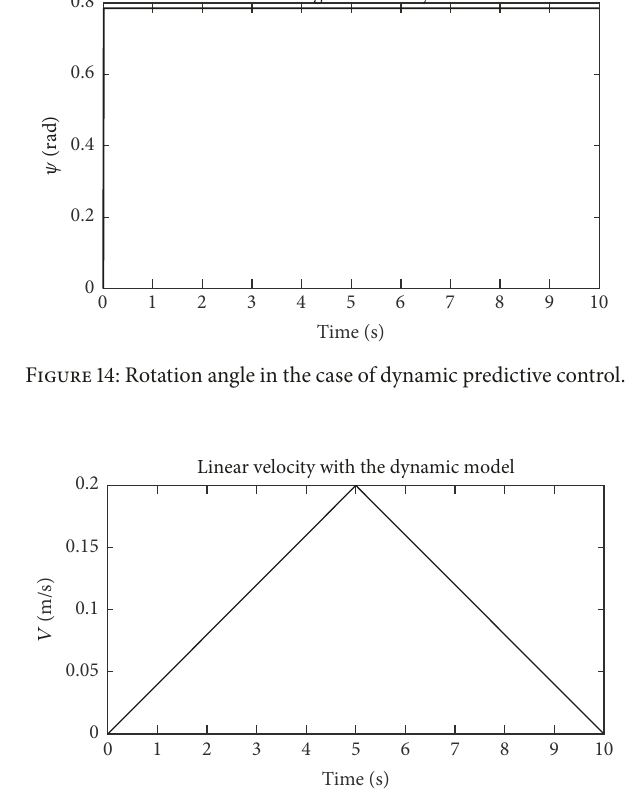
Figure 15: Linear velocity in the case of dynamic predictive control.